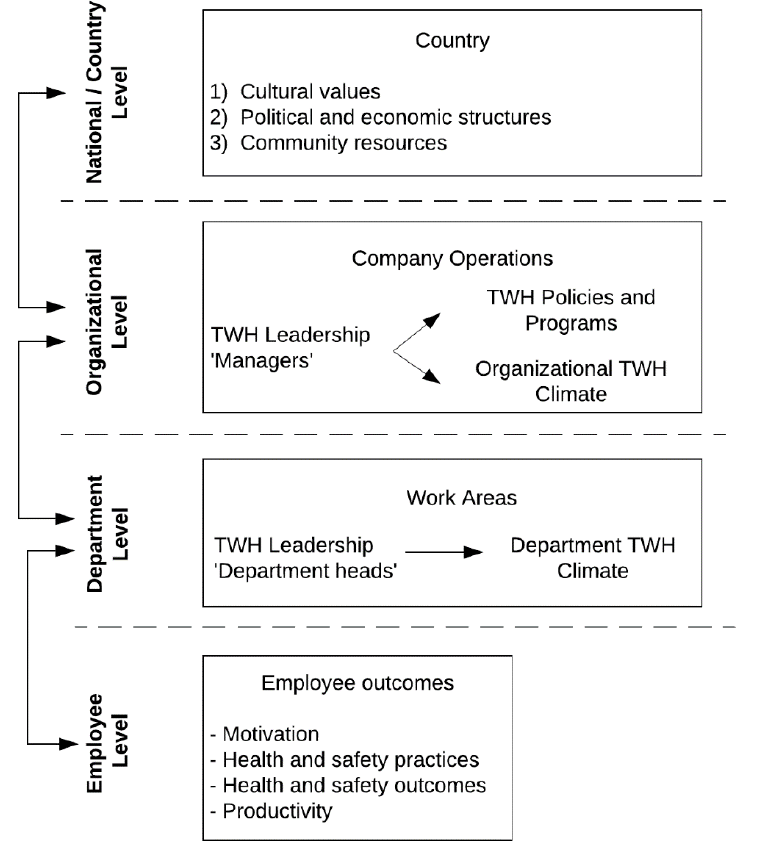
Figure 1. International Total Worker Health (TWH) Conceptual Model.